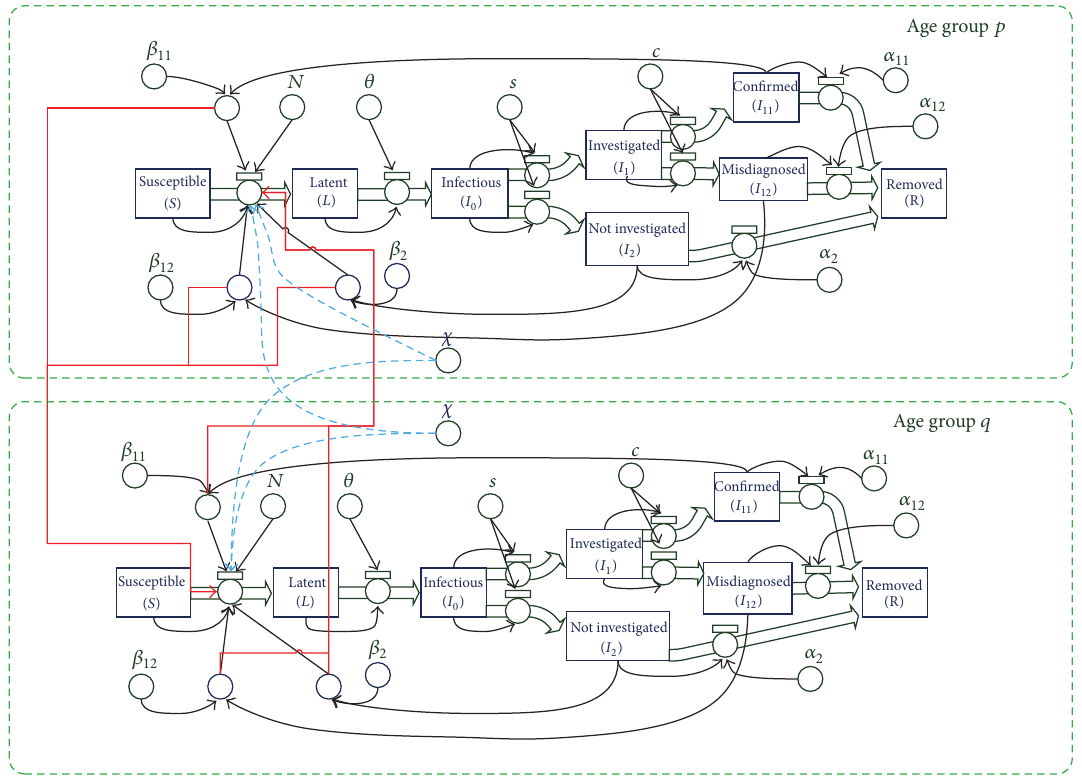
Figure 5: System dynamics flowchart between two modified age-structured SLIR compartmental models in layer 2 of the FLUed model. Red lines indicate parameters for other age groups. Blue curves indicate relative percentages of each age group within the total population at each